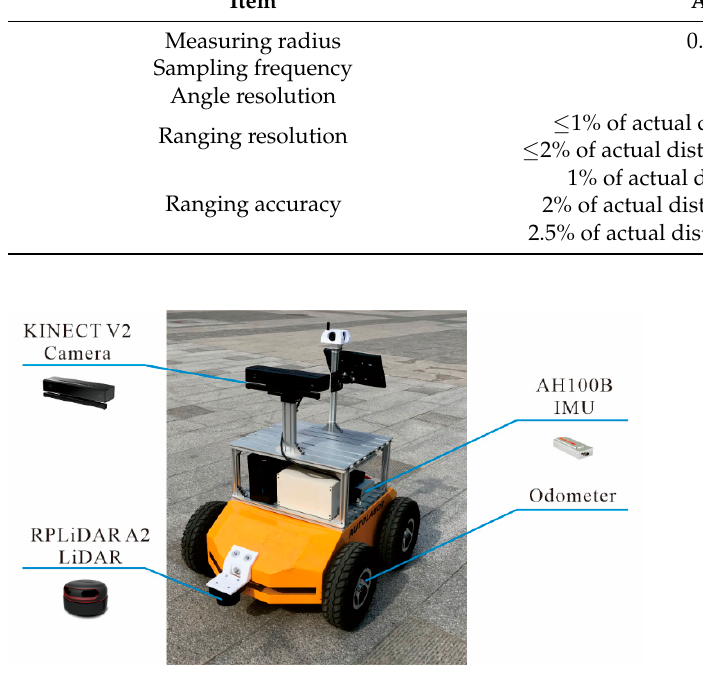
Figure 4. The laboratory environment scene; ( a ) actual scene, ( b ) schematic diagram. 4.3. Experimental Steps Step 1: Data acquisition. In the first group of experiments, the EuRoC public dataset is selected as the data source. In the second group of experiments, however, the Autolabor was used to collect environmental data from the laboratory. Step 2: Weighted coefficient determination. For the WPF method, the key is to determine the proportion of camera pose and IMU pose. In this paper, the weighted relation between camera pose and IMU pose is deter- mined according to the matching success rate 𝜇 of the feature points successfully matched by two keyframes to the total feature points, which is the weighted coefficient 𝜆 of the pose fusion. Firstly, we selected some indoor environment scenes and the images were shot using a KINECT camera. The feature points between the images are matched to calculate the pose. The IMU integral is then used to record the acceleration and angular velocity, and obtain the pose. The common pose solution methods directly use EKF to obtain the pose of the robot. Therefore, it can be used as the truth value for the experi- mental comparisons. Secondly, the root mean square error (RMSE) values between the pose calculated by camera/IMU and the fusion pose calculated by EKF are calculated. Fi- nally, the relationship between the matching success rate 𝜇 and the RMSE of the pose is analyzed. If the matching success rate 𝜇 is different, the relationship between KINECT camera and RMSE calculated by IMU is analyzed. The weighted coefficient 𝜆 of the fu- sion of camera pose and IMU pose is accordingly determined. Step 3: Pose solution.